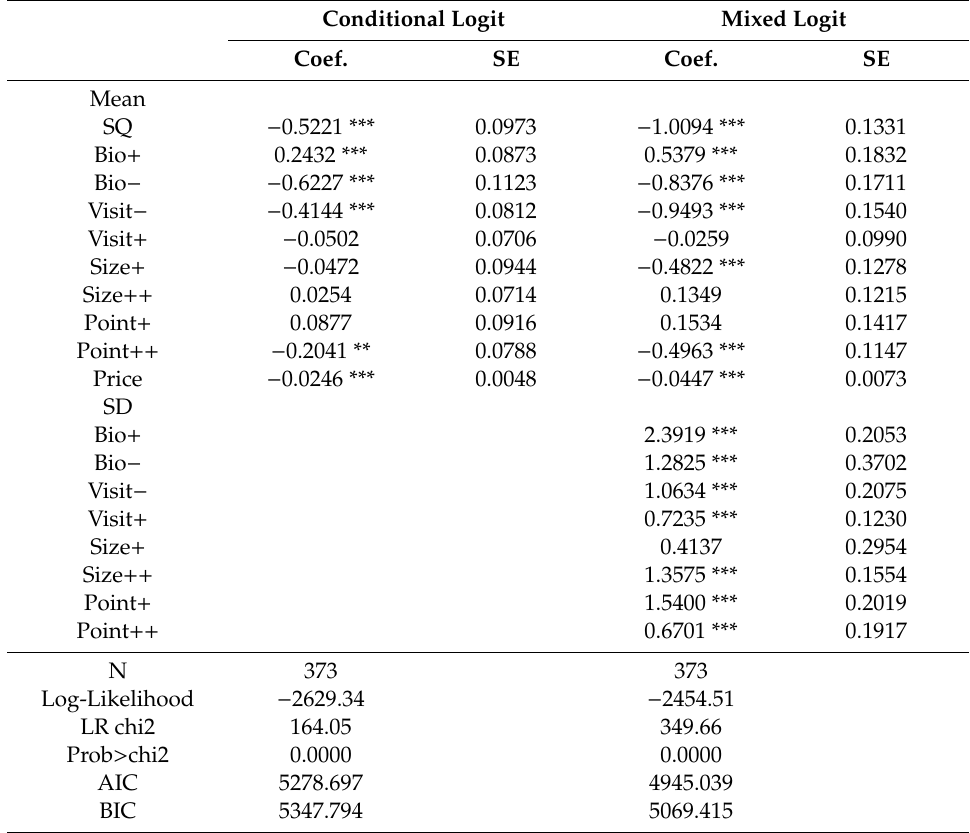
Table 4. Conditional (fixed e ff ects) logit and mixed